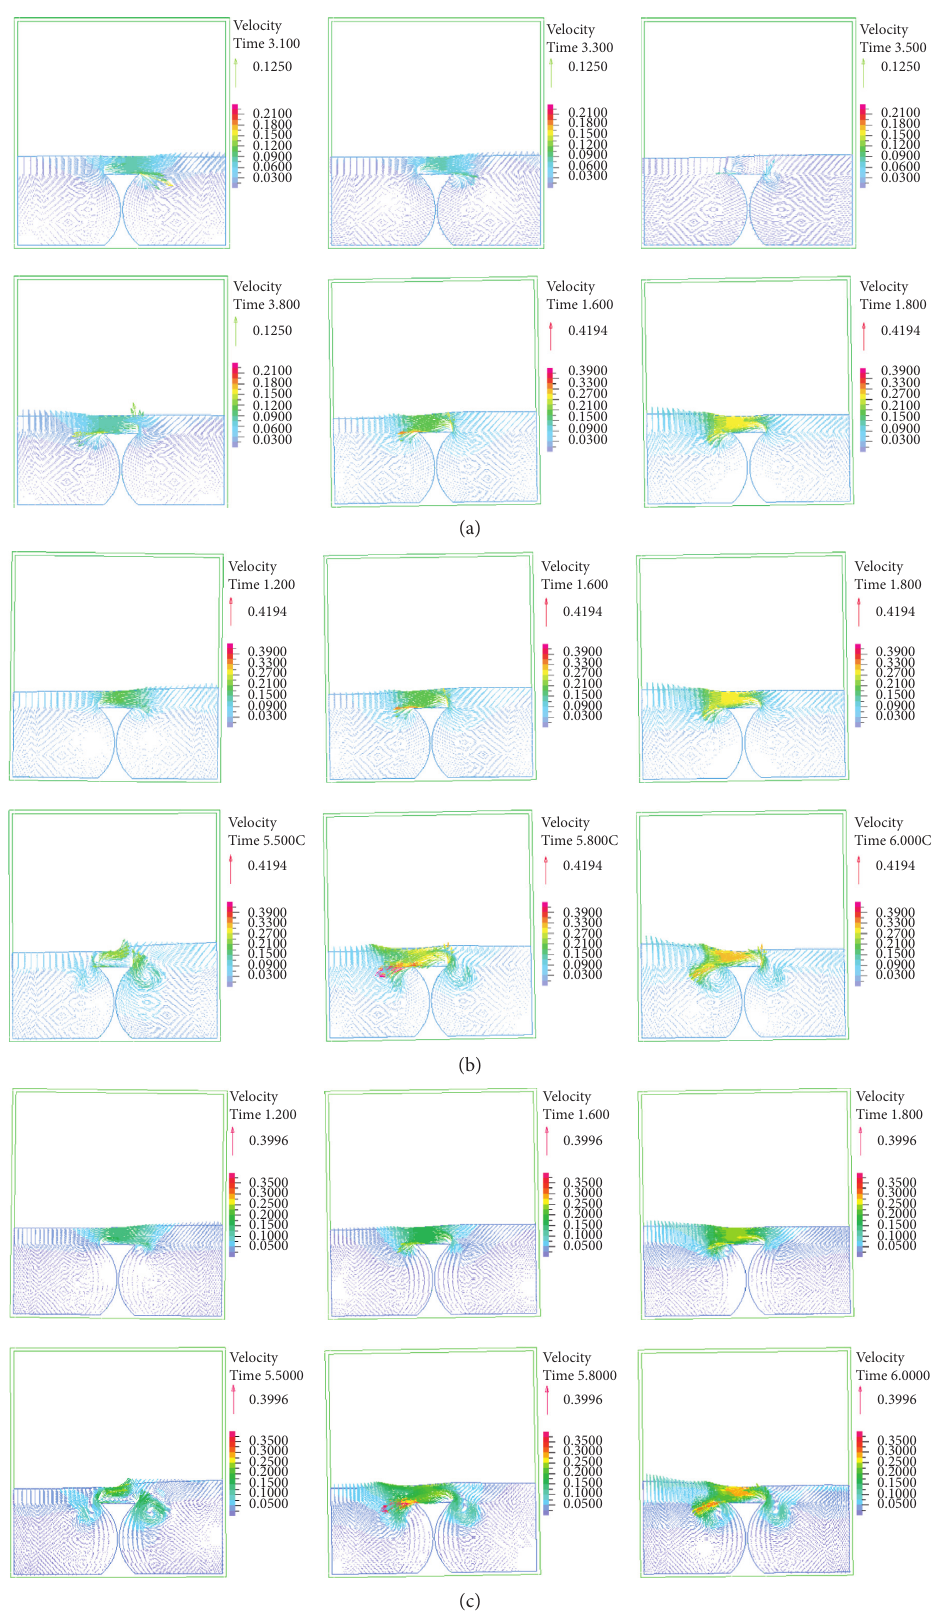
Figure 16: Evolution of velocity field under (a) surge excitation; (b) pitch excitation; (c) coupled excitation of surge and